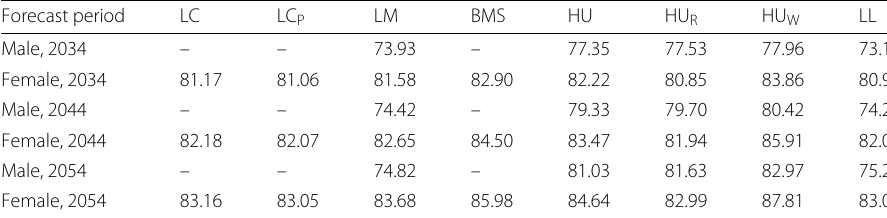
Table 8 Forecast of life expectancies at birth for Hungarian males and females Forecast